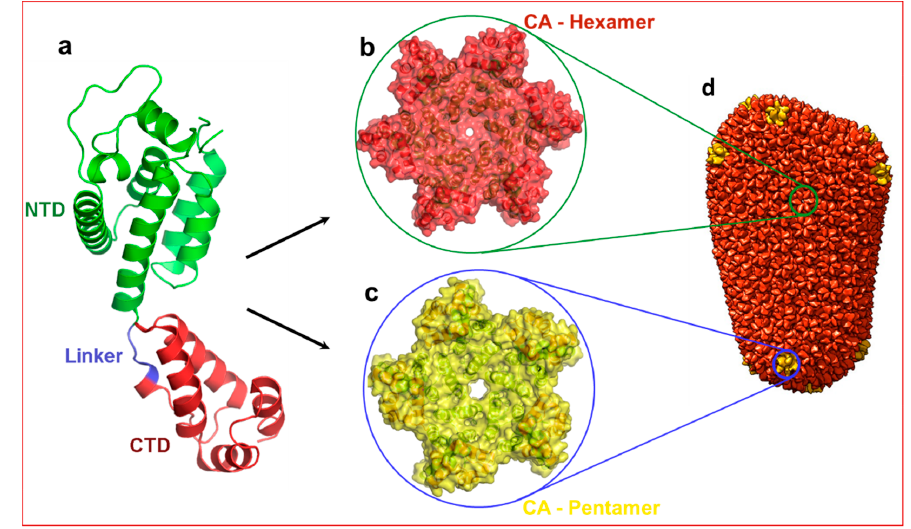
Figure 1. Structure of HIV-1 capsid . ( a ) Structure of capsid (CA) monomer. This figure was generated from the X-ray crystal structure of native HIV-1 capsid protein bound to PF74 [9] (PDB entry 4XFZ). NTD: N-terminal domain. CTD: C-terminal domain. Panels ( b , c ) show hexamer and pentamers formed from the same CA monomer. ( d ) Approximately 250 hexamers and 12 pentamers form a conical shaped capsid that houses necessary and sufficient components to initiate reverse transcription immediately after infection. Panel d is reproduced from PDB101 with permission.